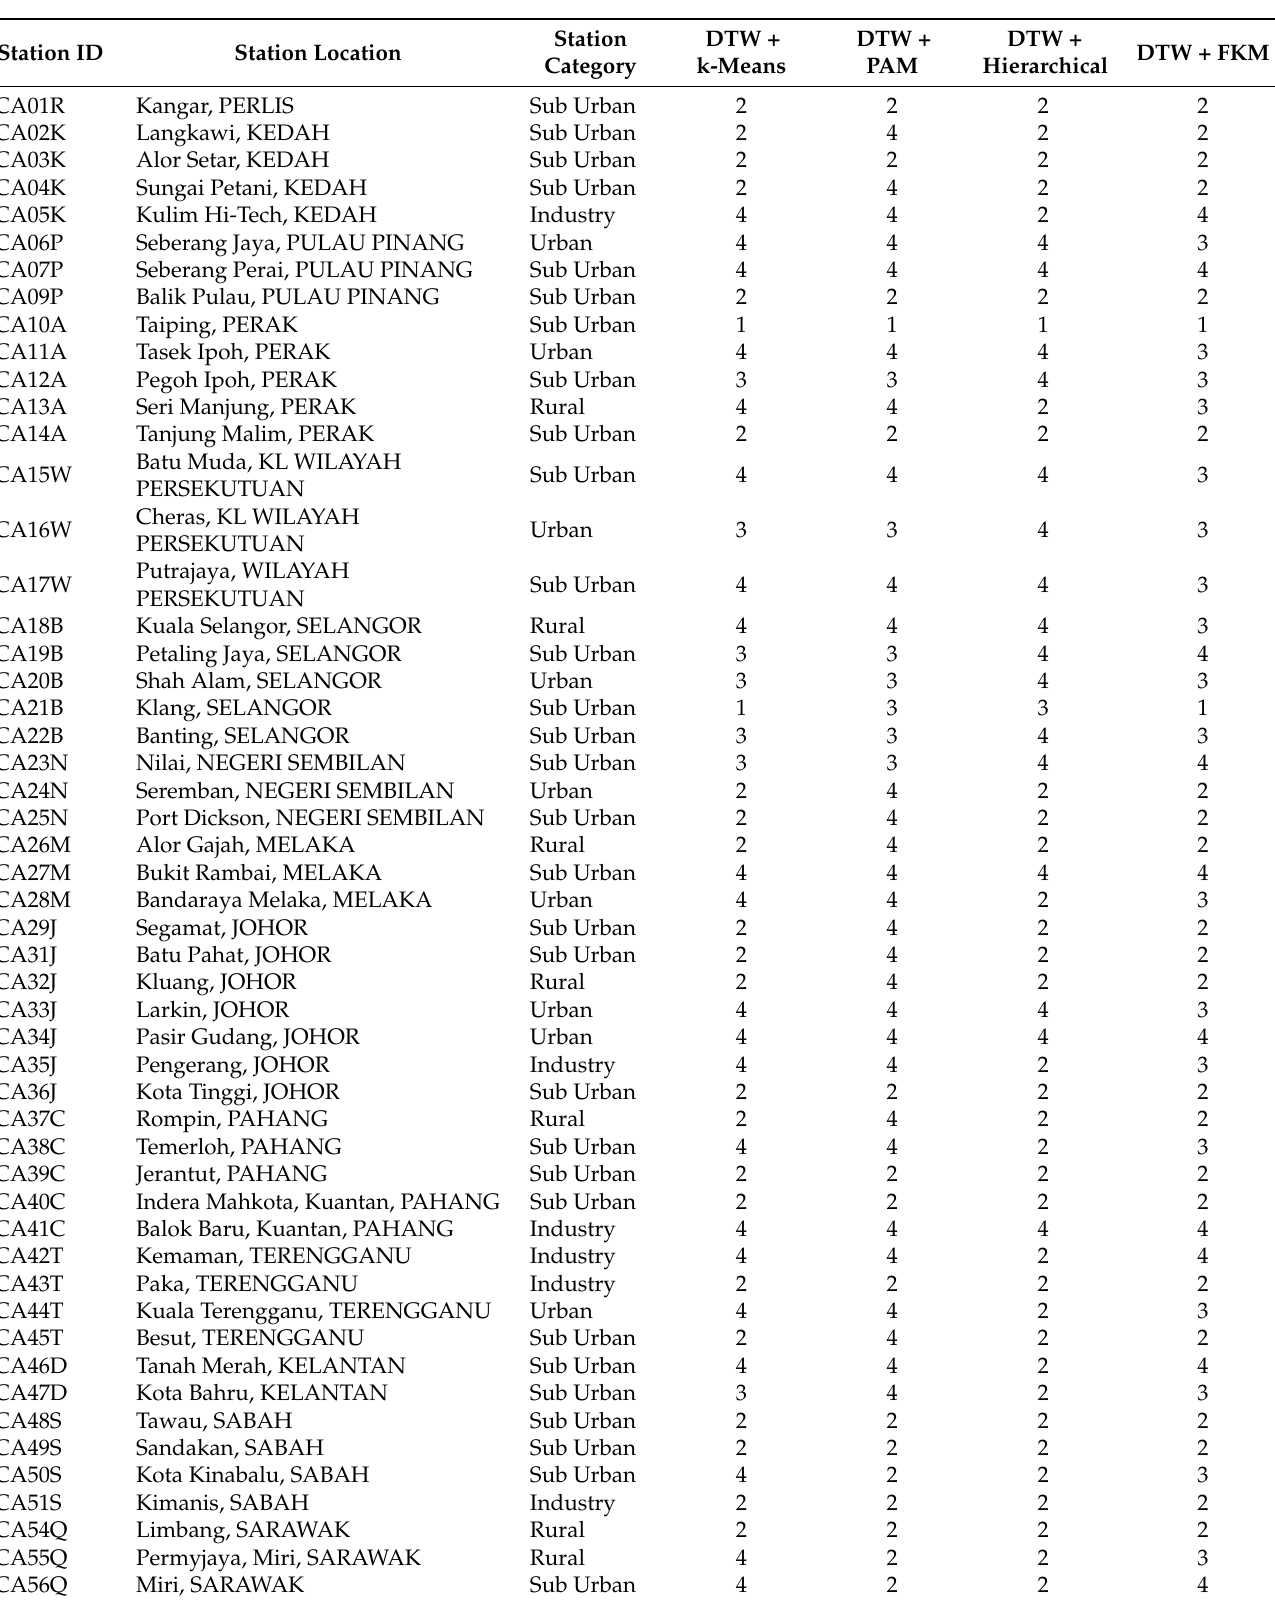
Table 5. Cluster membership for PM 10 daily maximum data according to stations based on four clustering